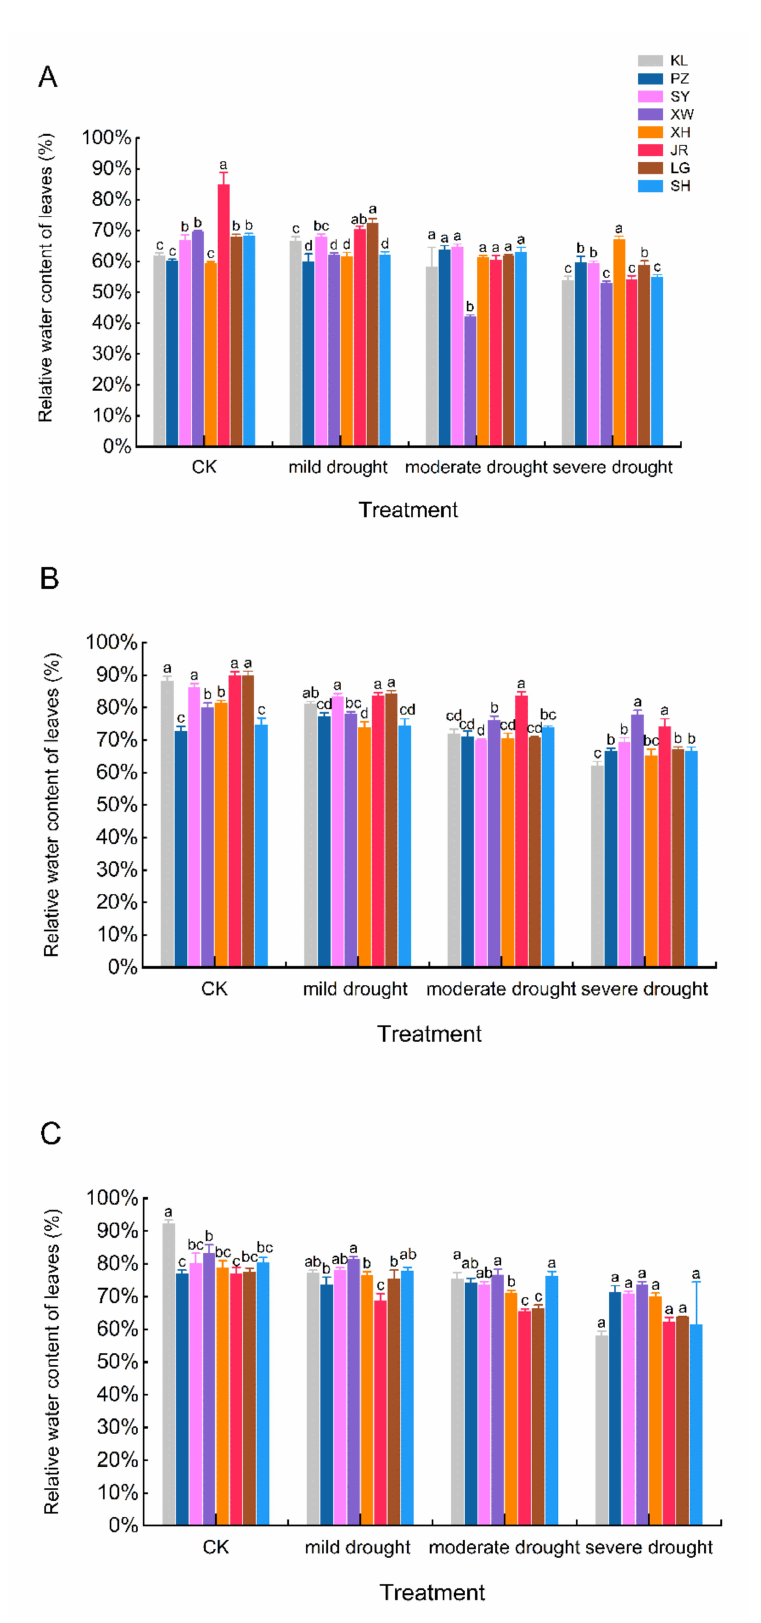
Figure 1. The relative water content in the leaves of Melia azedarach among different provenances: ( A ): early stage, ( B ): middle stage, and ( C ): late stage. Note: The error line in the figure is the mean ± standard error, and different lowercase letters in the same treatment indicate significant differences at the 0.05